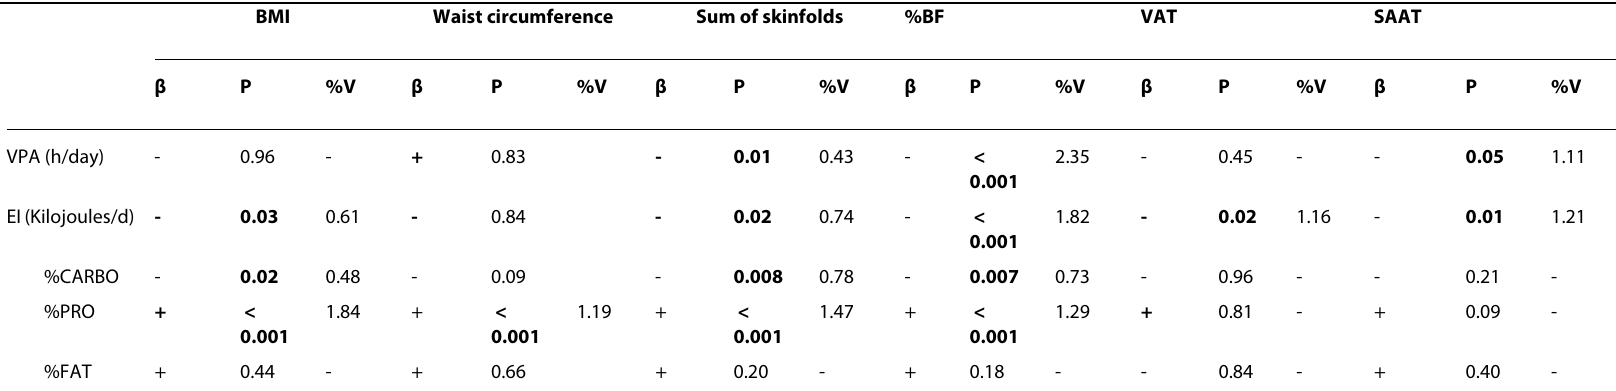
Based on the model with age, gender, ethnicity, cohort and the interaction of gender and ethnicity. Negative and positive indicate the direction of relation between the predictor and dependent variables. P < 0.05 are indicated in bold. %V = explained variance. BMI = body mass index; %BF = percentage of body fat; VAT = visceral adipose tissue; SAAT = subcutaneous abdominal adipose tissue; VPA = vigorous physical activity; EI = energy intake; %FAT = percentage of energy from fat; %CARBO = percentage of energy from carbohydrates; %PRO= percentage of energy from